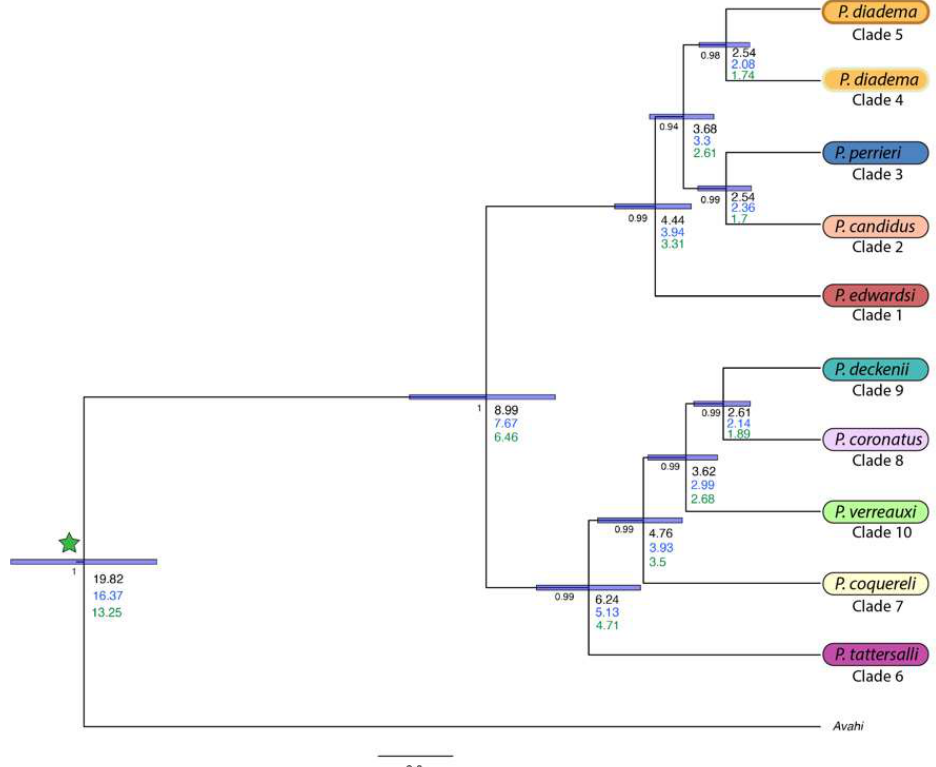
Figure 2. Divergence dated tree including UCE data generated in BEAST v1.8.4 [72]. Note the star at the root of the tree represents a calibration point as recovered from either [67]; the 10K primate tree [66] or [68], with different age estimates represented in black, blue, and green, respectively. Posterior probabilities are shown to the left of the ages (in millions of years) for all nodes. HPD bars shown were recovered from the [67] calibrated BEAST analysis. Table 2. Divergence date comparisons with three different age constraints for the Avahi–Propithecus split [66–68]. Node age is shown with 95% HPD in parentheses, and all ages are shown in millions of